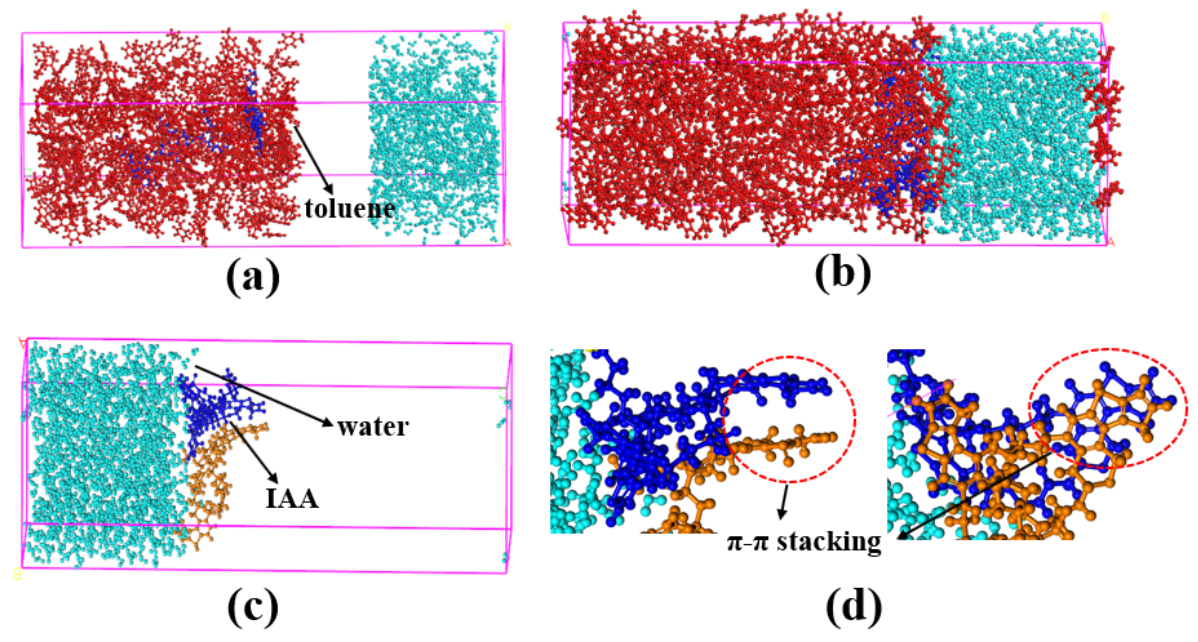
Figure 27. The adsorption of IAA at oil–water interface (( a ): initial configuration, ( b ): final configu- ration, ( c ): toluene molecules are hidden, ( d ): local amplification). Reprinted with permission from Ref. [208]. Copyright 2021, copyright with the Elsevier. More details on Copyright and Liscensing are available via the following link: https://www.sciencedirect.com/.